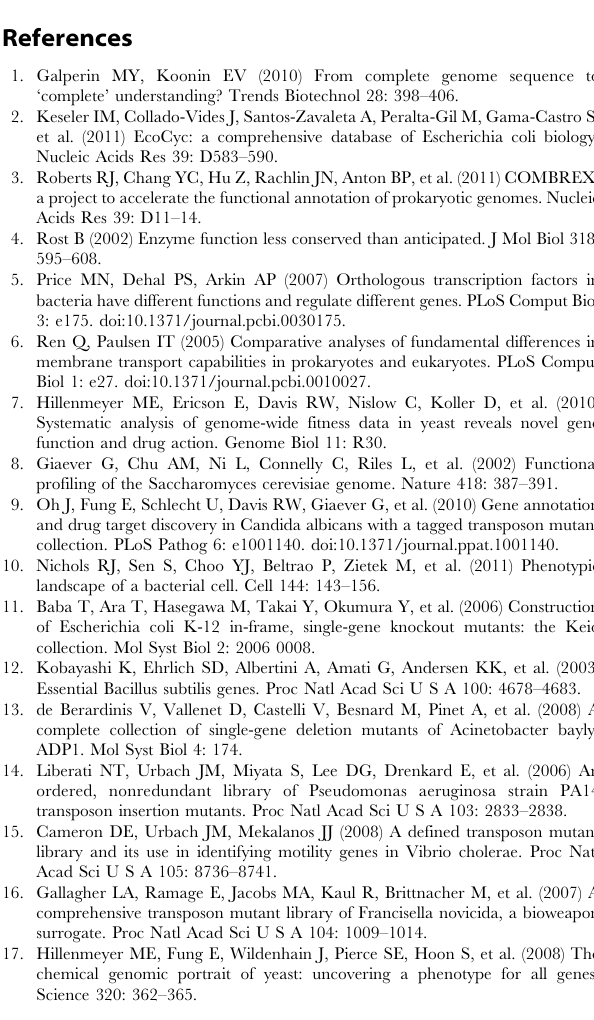
mutants on the main chromosome. (B) Same as (A) for 10,267 mariner transposon mutants. Figure S8 Survival of S. oneidensis MR-1 after heat shock, cold adaptation, and stationary phase. Survival of MR-1 after heat shock at 42 u C for different lengths of time. The survival plots of the upPool and dnPool are plotted separately. Cells were plated on LB plates and counted after 2 days of growth. (B) Same as (A) for cold survival